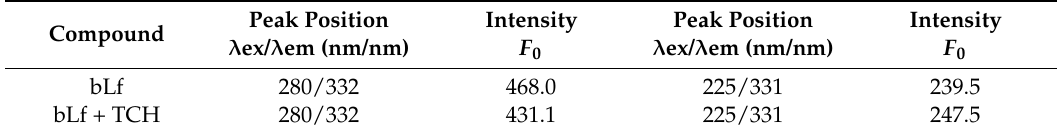
Table 4. TCH–bLf binding studied by